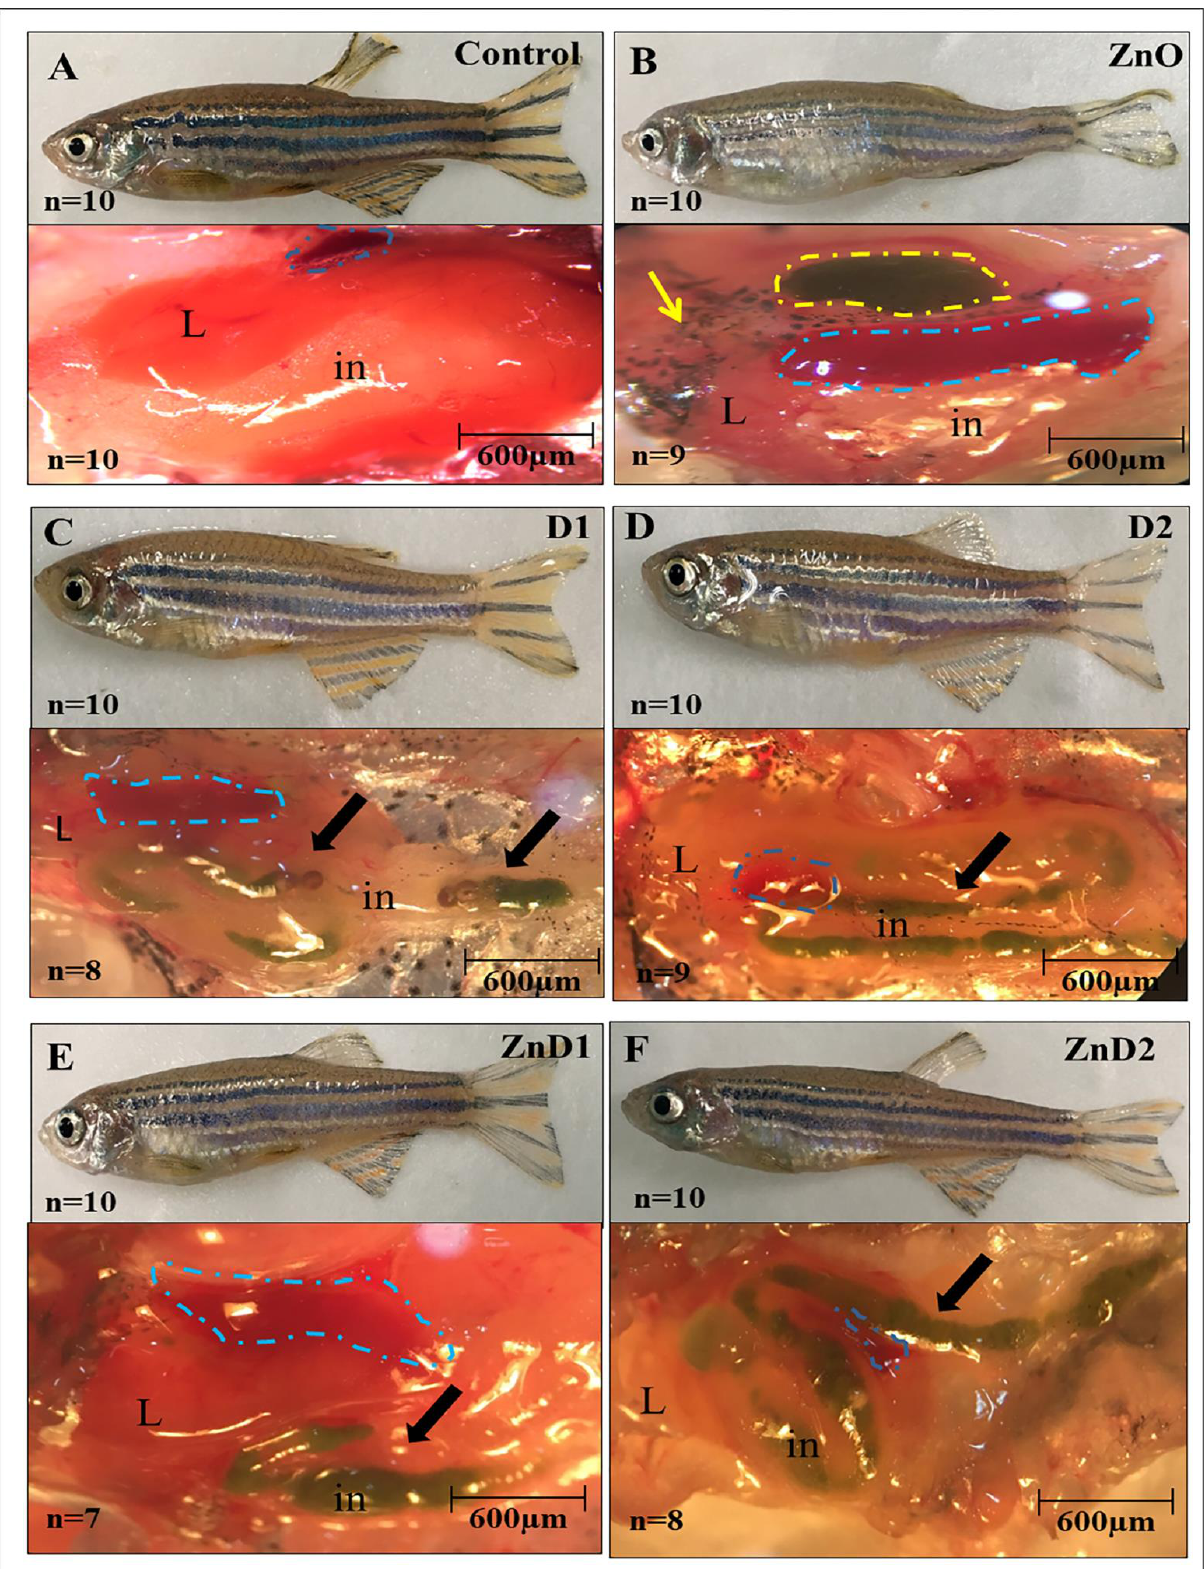
Figure 2. D. salina restored the fish appetite after ZnO-NPs exposure: ( A ) Representative pictures of the control zebrafish with a normal phenotype of the liver, intestine, and spleen (Blue dashed line); ( B ) photographs for ZnO-NPs exposed fish with whitish skin color, feeble irregular body,